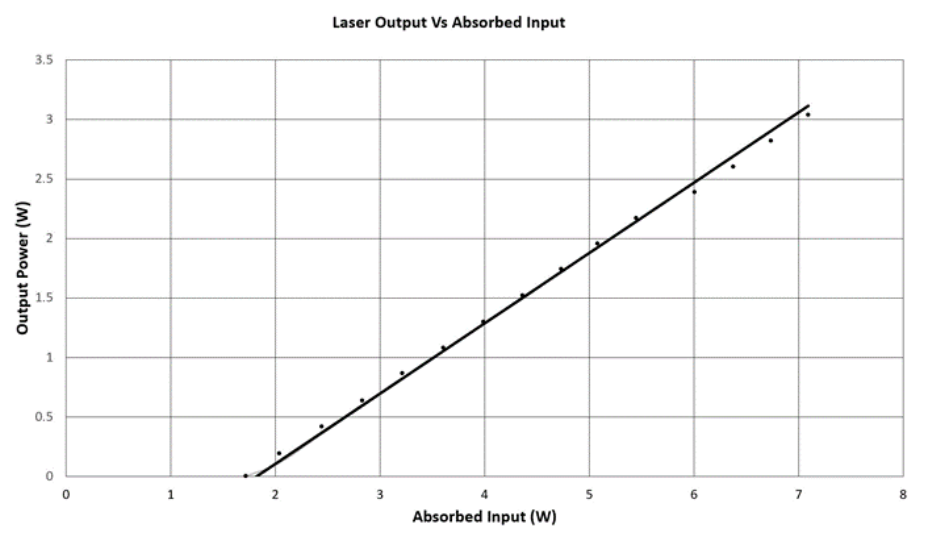
Figure 4. Laser Output vs. Absorbed Input.